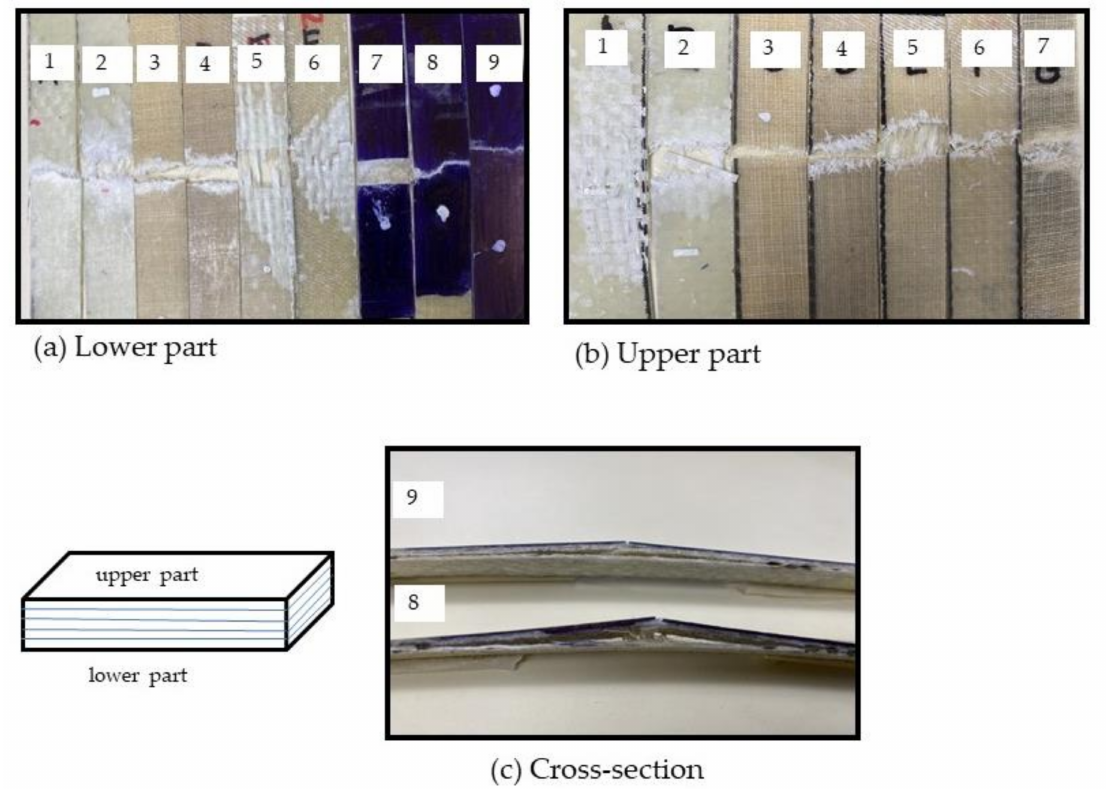
Figure 4. Digital images of the tensile fractures of the ( a ) lower part, ( b ) upper part, and ( c ) cross section of the lami- nated